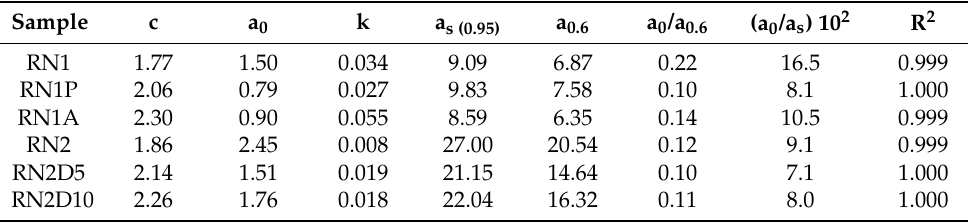
Table 6. Dubinin-Serpinsky (DS) parameters estimated from water adsorption at 30 ˝ C on the